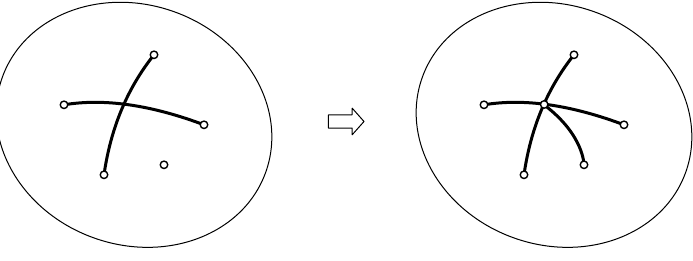
Figure 1: An example of 3-dimensional 2-extension